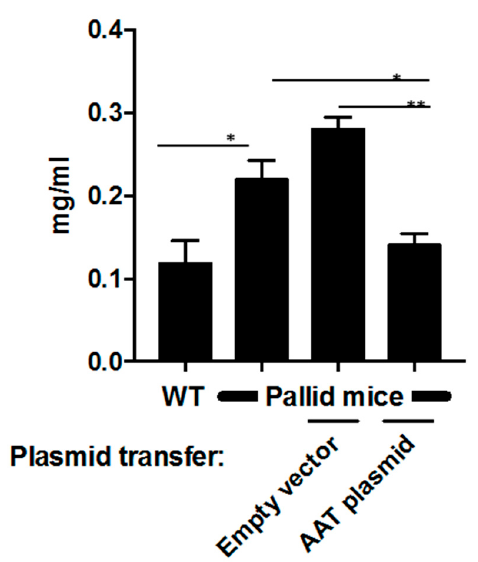
Figure 5. Bronchioalveolar lavage (BAL) fluid neutrophilic activity: After electroporation-mediated hAAT gene transfer, myeloperoxidase assay (MPO) was performed to assess the neutrophil activity in BAL fluid. Data are shown as mean ± SD, unpaired t test was performed, and each group was compared to each other * p < 0.05, ** p < 0.01.